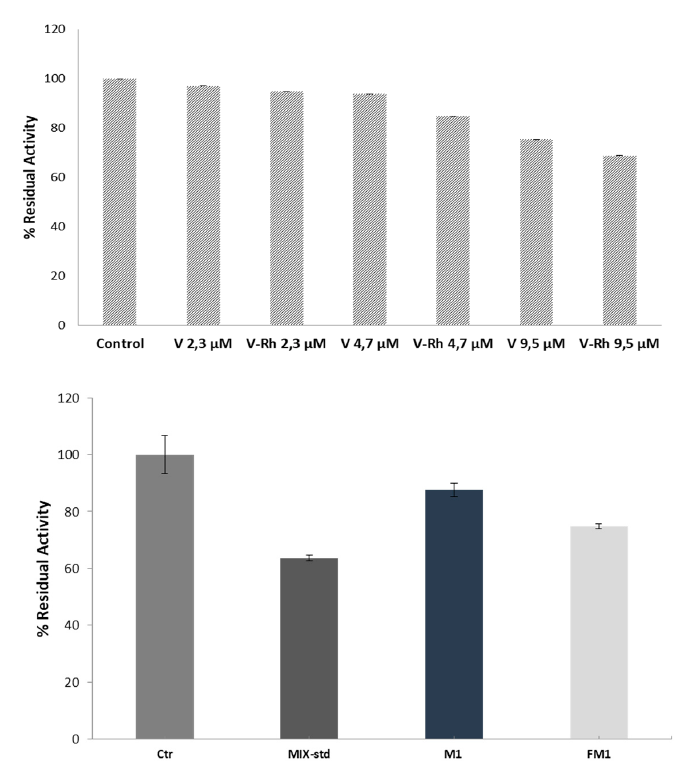
Figure 5. In vitro activity (as % of residual activity) of PTP1B enzyme. ( a ) vitexin (V) and vitexin 2”- O -rhamnoside (V-Rh), both tested at three concentration values: 2.3 µM, 4.7 µM and 9.5 µM. ( b ) comparison among a mixture of the two flavonoids (MIX-std) both at 9.5 µM and unfermented(M1) and fermented (FM1) extracts containing vitexin and vitexin 2”- O -rhamnoside at a concentration of approximately 9.5 µM, as mean value.